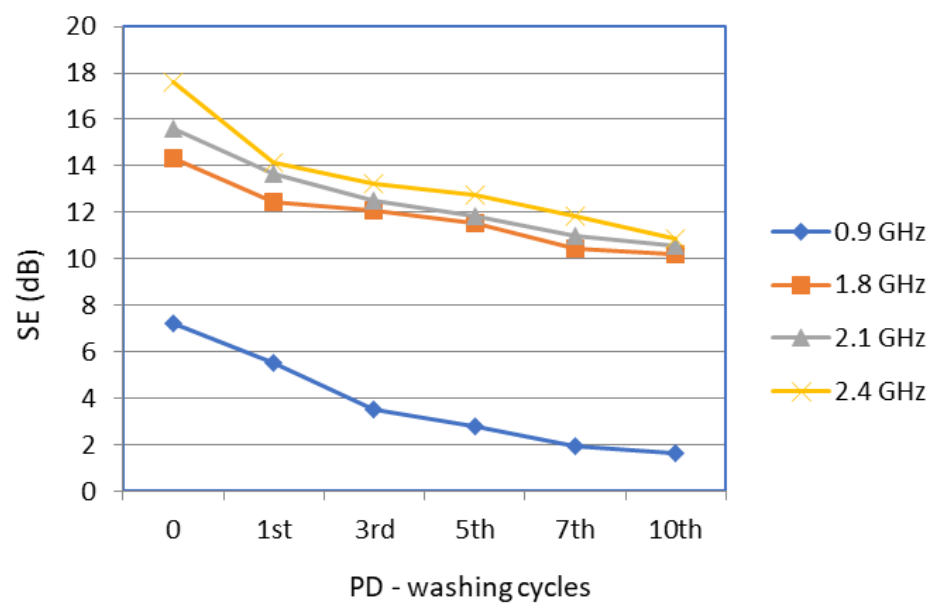
Figure 5. Shielding effectiveness (SE) of stainless-steel fabric sample (face) before and after the 1st, 3rd, 5th, 7th, and 10th washing cycles with powder detergent at frequencies 0.9 GHz, 1.8 GHz,